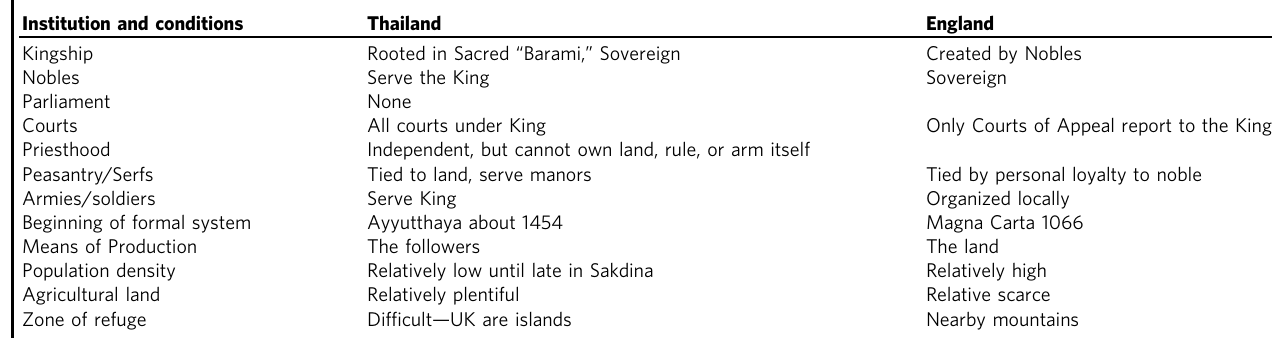
Table 1 Summary of differences highlighted in Kukrit ’ s Farang Sakdina between English/farang feudalism, and Thai Sakdina, as speci fi ed in Farang Sakdina , by Kukrit